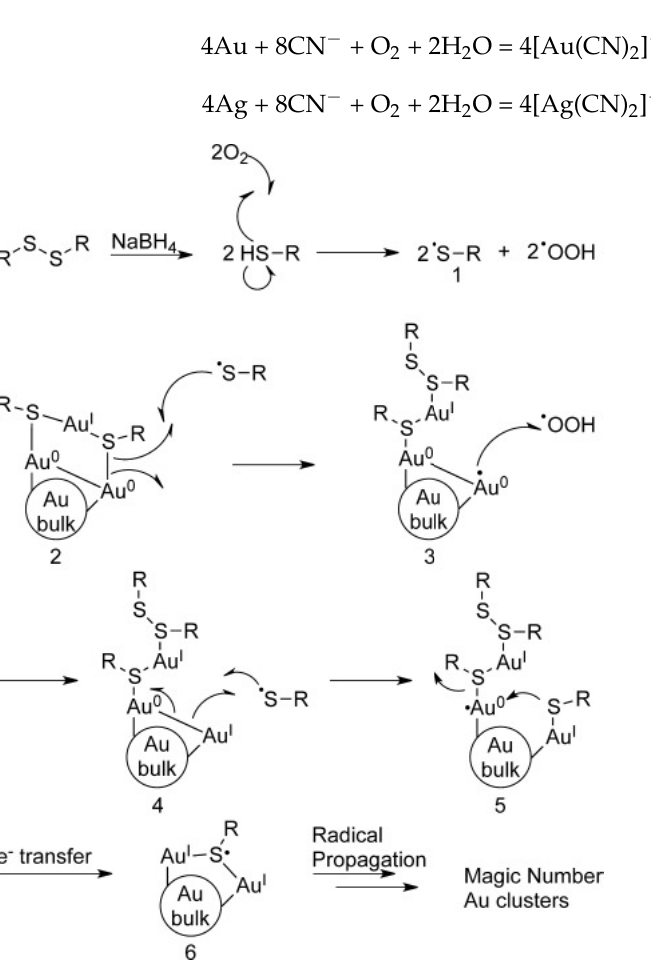
Figure 4. Etching mechanisms dependent on oxygen radicals. Reprinted with permission from Ref.